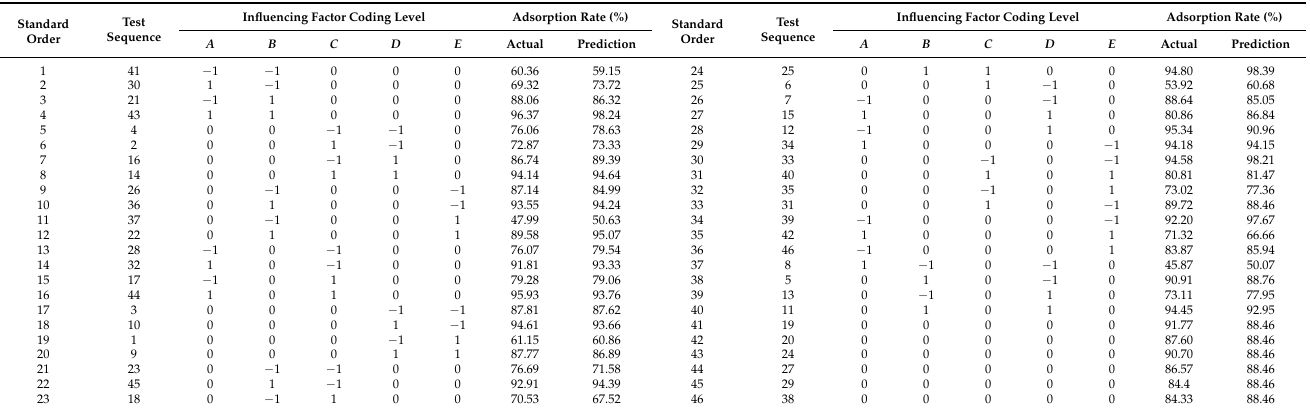
Table 2. Experimental design of Box–Behnken and the removal efficiency for